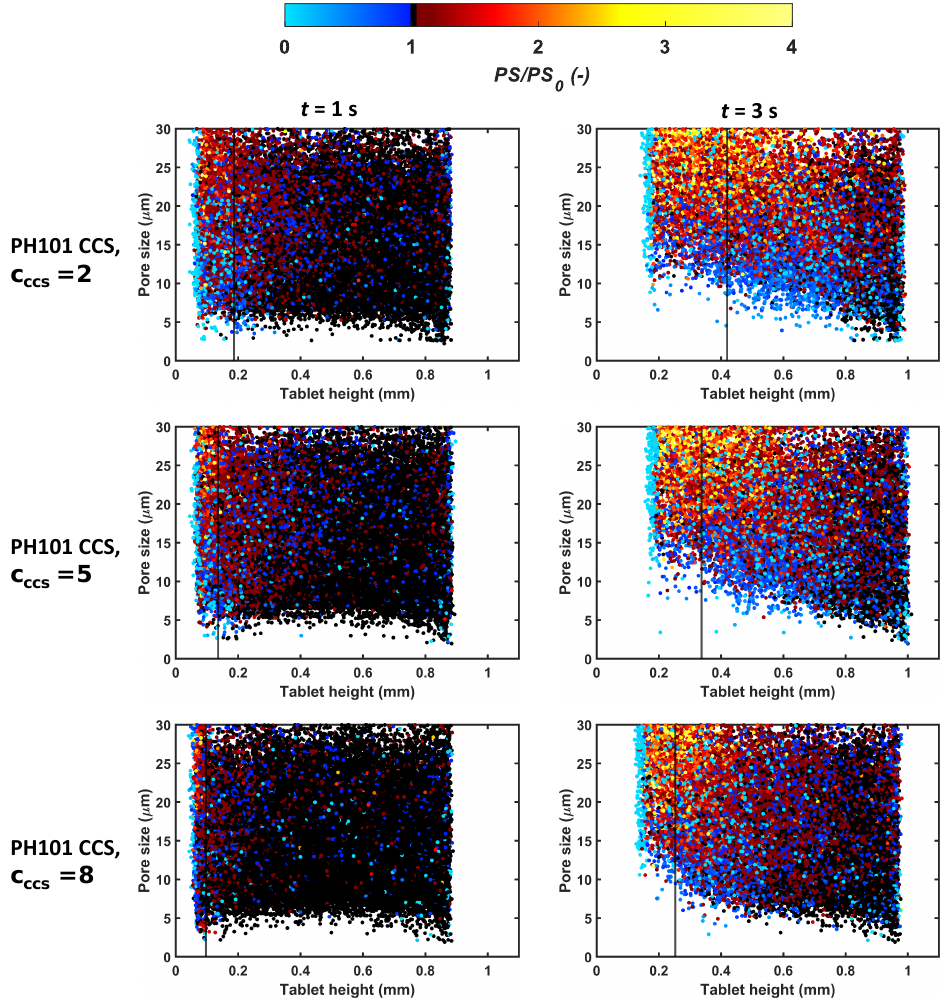
Figure 12. The pore size ratio (PS/PS 0 ) as a function of tablet height focusing on pores <30 µ m during swelling at 1 s and 3 s. The black vertical line in each plot indicates the liquid front at that particular time point. PS is the pore size at time t, and PS 0 is the pore size at t = 0